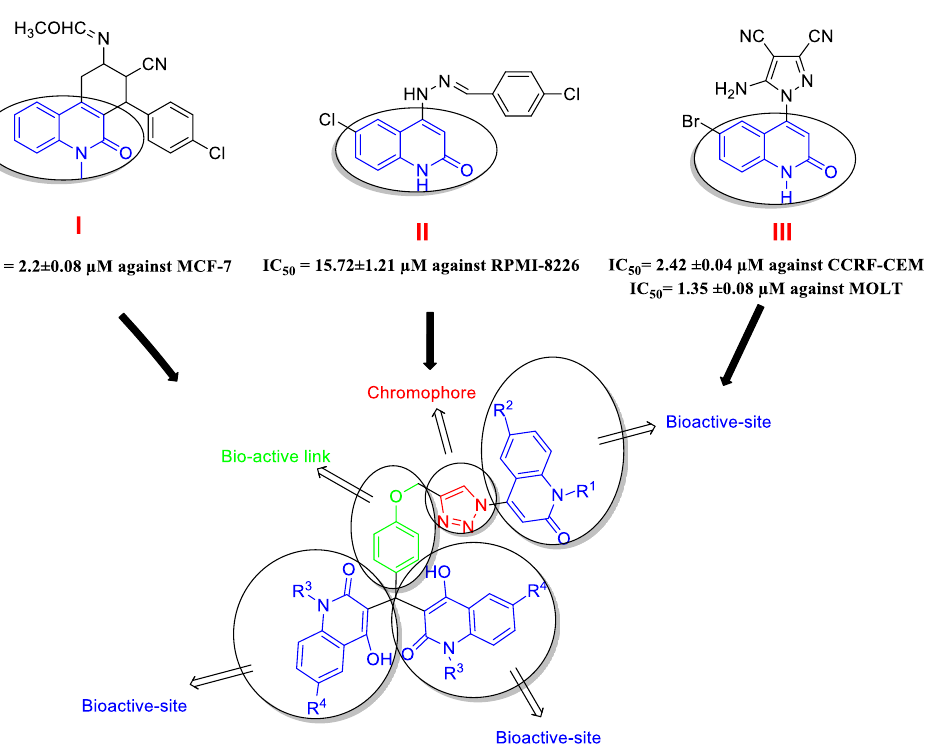
Figure 1. Bioactive sites and chromophore group in the designed compounds 8a – l .